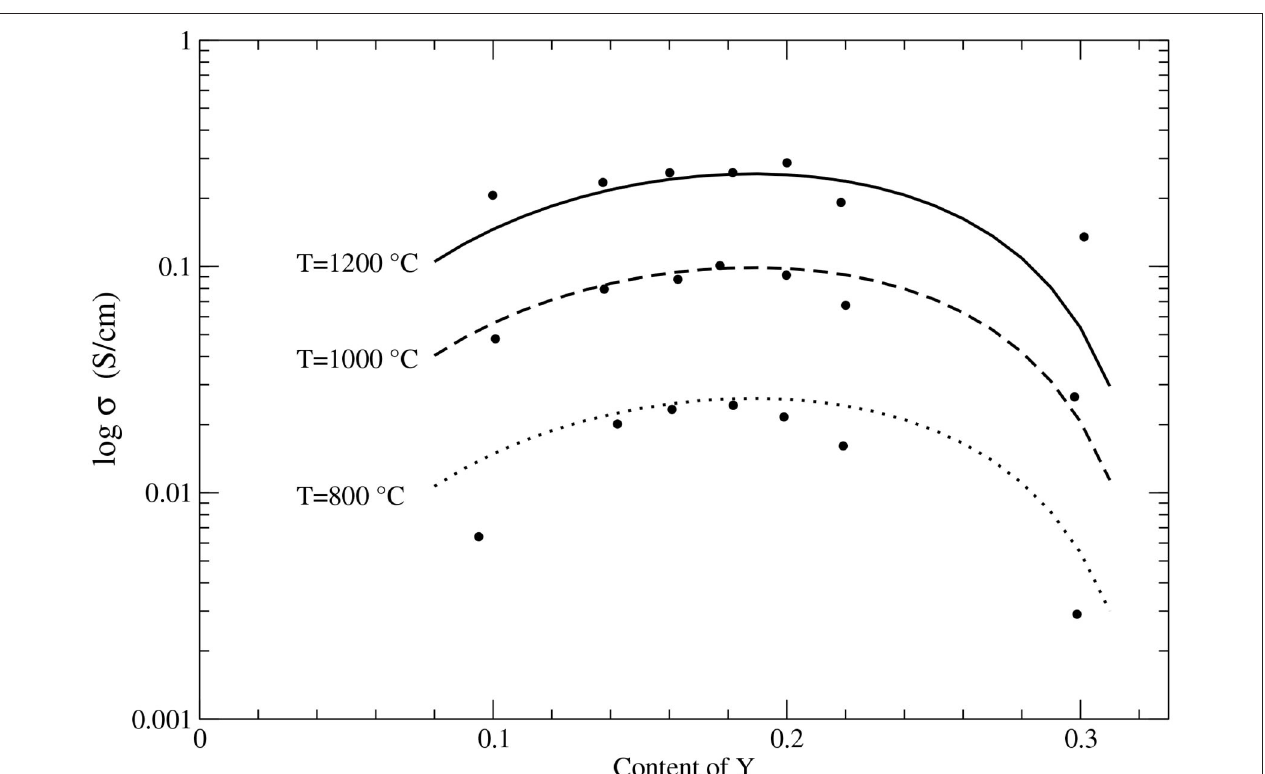
FIGURE 5 | The computed (lines) ionic conductivity in YO 1.5 − ZrO 2 system. The data (black filled circles) come from Strickler and Carlson (1964) and Liu et al. (2016).